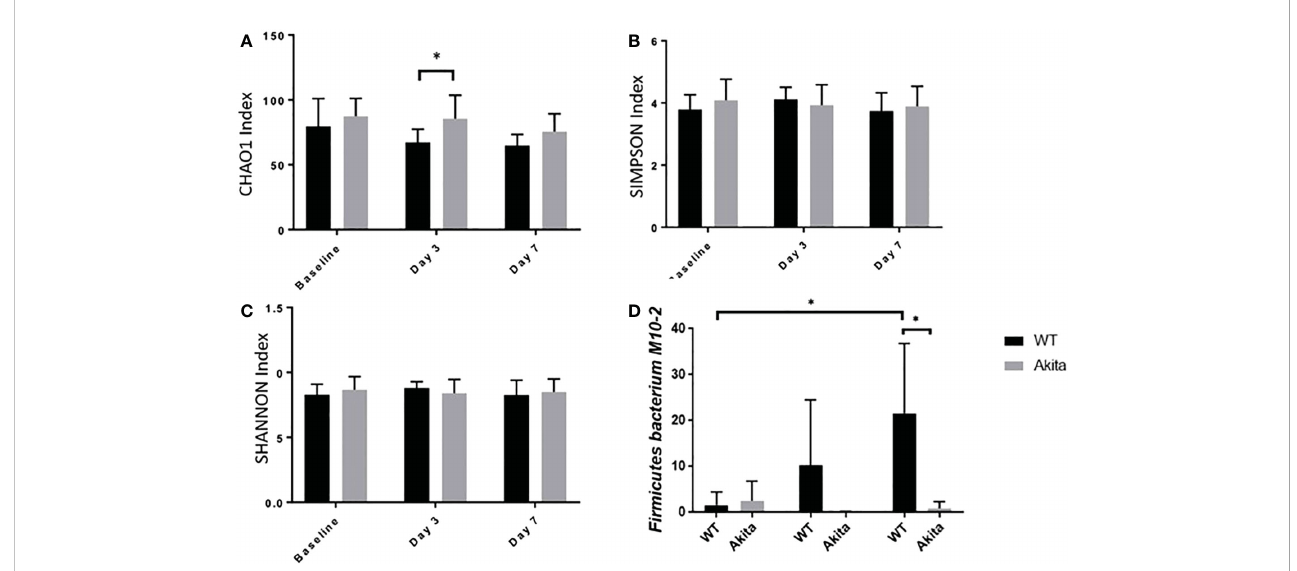
FIGURE 6 Comparison of intestinal microbiome diversity pattern of WT and Akita mice measured at baseline (before injury) with day 0, day 3, and day 7 aftercorneal alkaline injury. (A) Comparison of alpha diversity index at baseline, day 3, and day 7 after injury. Akita mice were found to have higher abundance ofmicrobiota composition as compared to WT mice from the CHAO1 index at day 3 after injury (n = 7, p = 0.0376). (B, C) Comparison of alpha diversity index at baseline, day 3, and day 7 after injury by the SIMPSON index (B) and SHANNON index (C) at day 3 after injury. No signi fi cance difference was found at baseline, day 3, or day 7 after injury after one-way ANOVA test ( n = 7). (D) Firmicutes bacterium M10-2 had higher abundance in WT mice as compared to diabetic mice at day 7 after cornea alkaline injury ( n = 5, p = 0.0164); there was a signi fi cant increase of Firmicutes bacterium M10-2 at day 7 after injury as compared to baseline level for WT mice ( n = 5, p = 0.0215) ( n number means the number of mice from both the WT and Akita groups, same for all measurements).